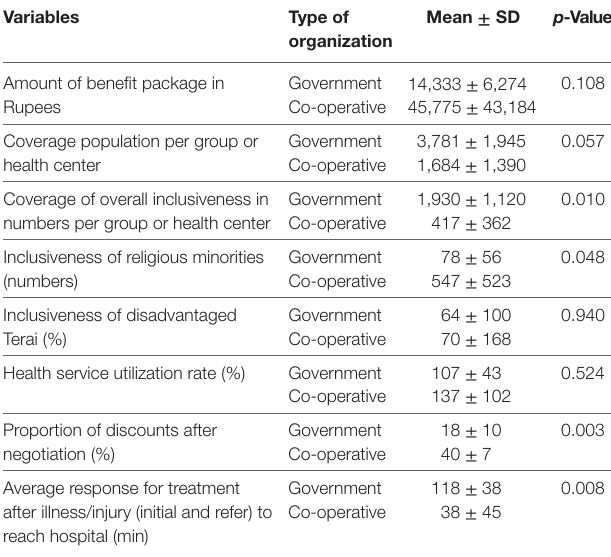
TaBle 4 | Comparison of health indicators between the two CBHI models. TaBle 3 | Descriptive comparison between government and community groups